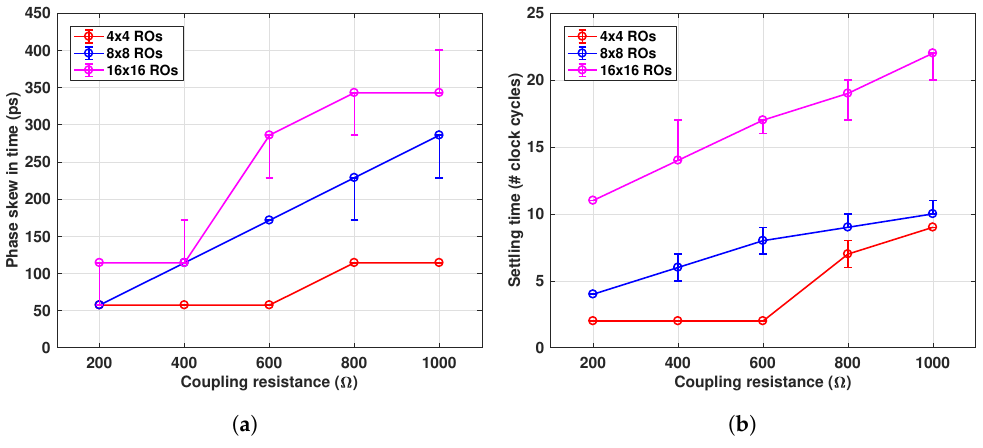
Figure 9. Steady state ( a ) phase skew and ( b ) settling time, for different network sizes and coupling resistance. Settling time is defined by the phase mismatch below 1/(67%) of value obtained in ( a ); vertical bars indicate variation due to ± 10% mismatch in R c